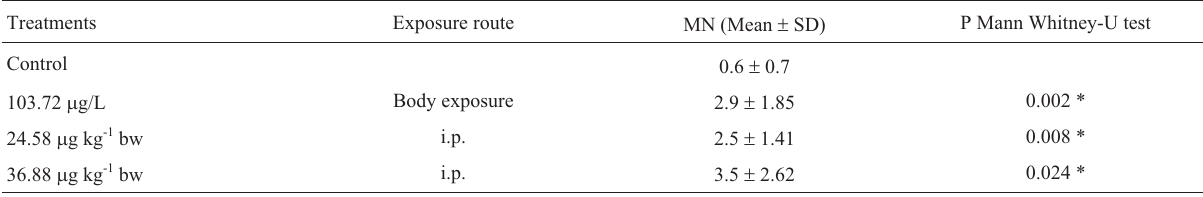
Table1 -Means(SD)ofmicronucleiin Astyanaxbimaculatus aftertreatmentwithextractsatdifferentconcentrations,consideringtwoexposureroutes. Treatments